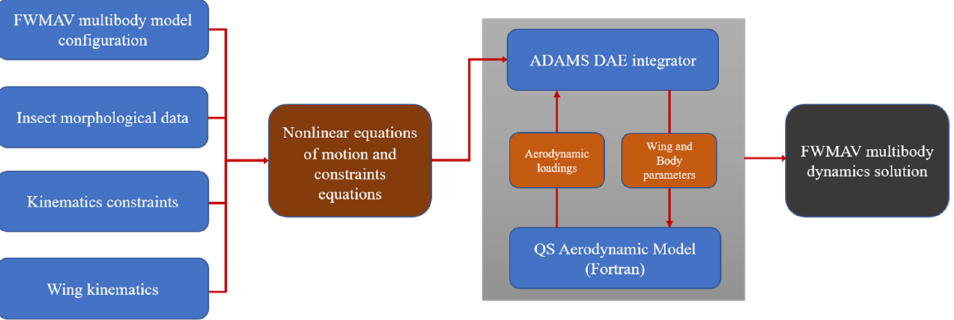
Figure 3. Multibody dynamics simulation framework for FWMAV